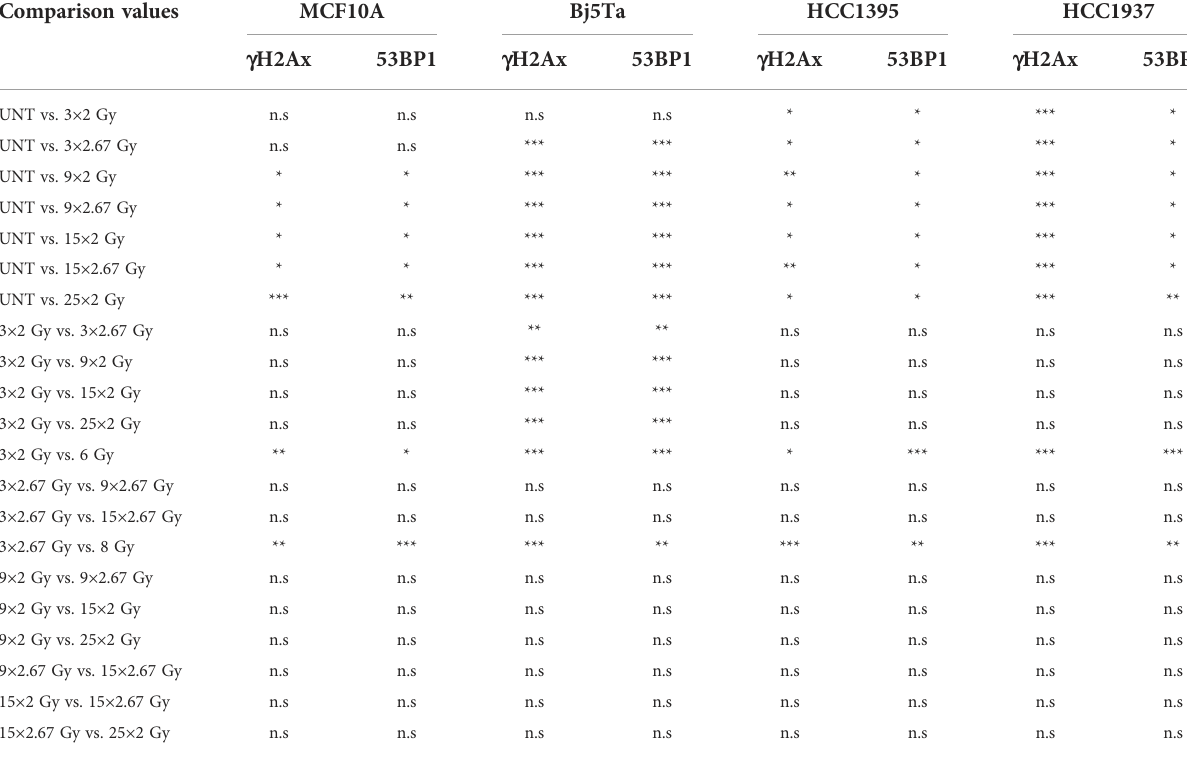
TABLE 1 Evaluation of DNA DSB repair ef fi ciency after hypofractionated and conventional multifractionated radiotherapy by means of residual foci. Comparison